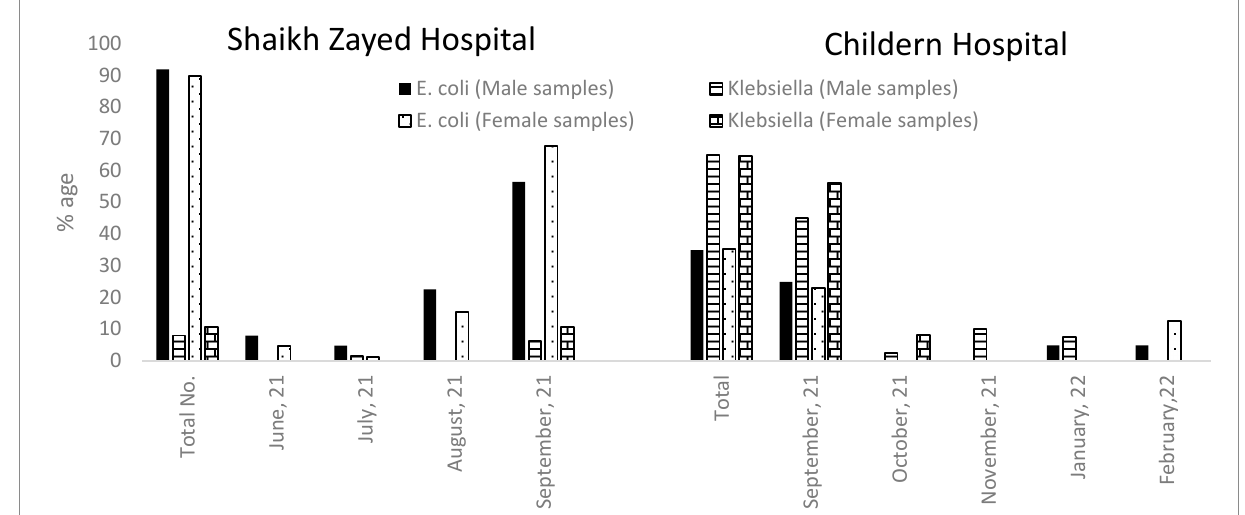
Figure 2. Month-wise distribution of Escherichia and Klebsiella from samples of pediatric patients (aged 0–6 yrs) at Shaikh Zayed and Children Hospital, Lahore, Pakistan .